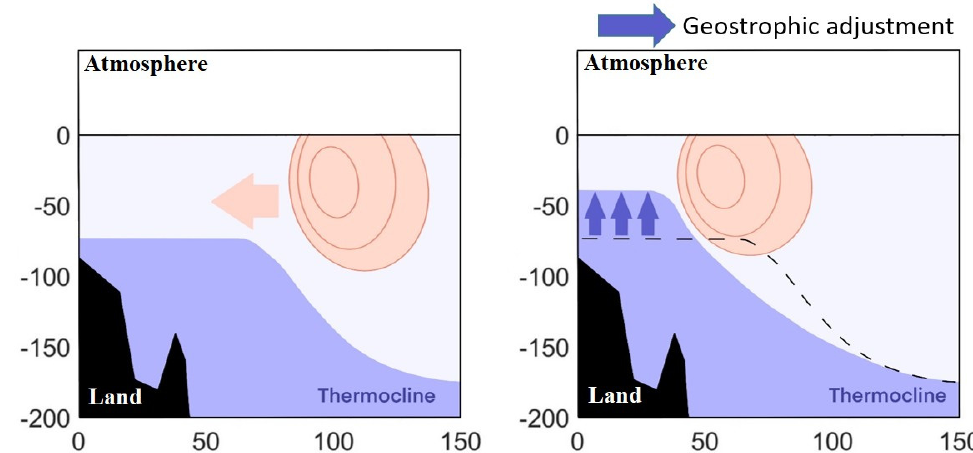
Figure 8. The schematic plot of the dynamic linkage between stronger alongshore (northward) flow and uplift of subsurface cold water surrounding Longdong. According to Tomczak and Godfrey [38], this upwelling is a result of the thermocline slope across a current. The oceanic temperature field reacts to the presence of a strong current by adjusting to geostrophic equilibrium. This process leads to a steep rise in the thermocline from the ocean towards the coast since isotherm depths on the oceanic side of the current cannot change. Orange circles denote the positions of strong current passing through (entering the paper). Dashed line in the right panel marks the original position of the thermocline before uplift.